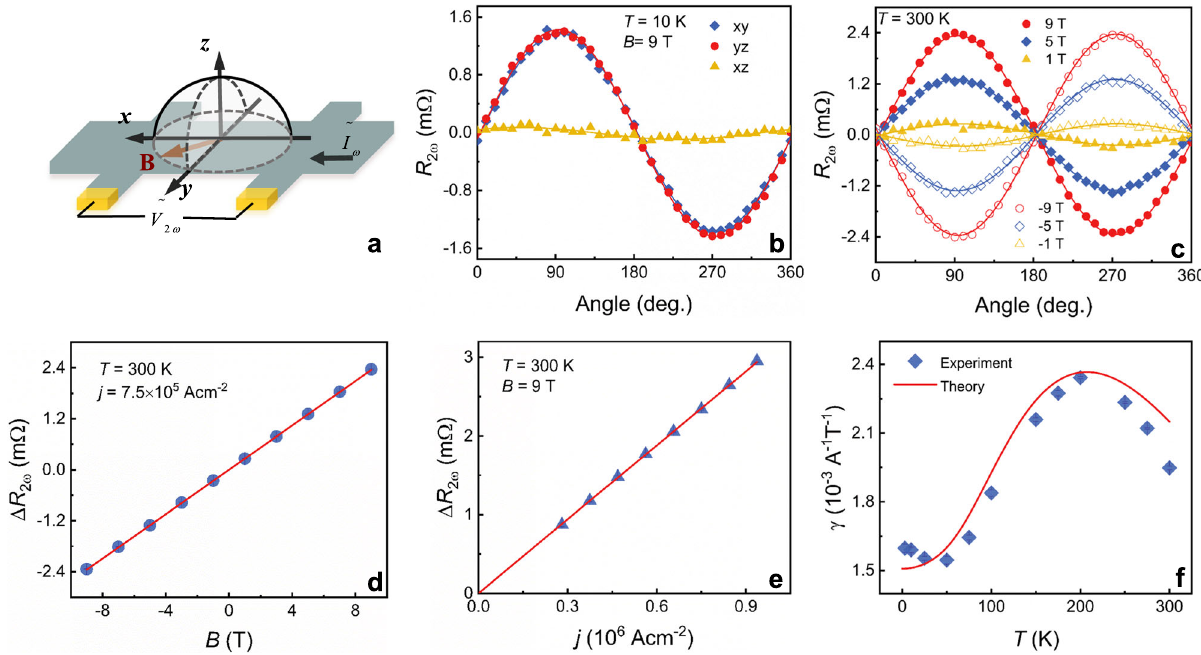
Fig. 2 Unidirectional magnetoresistance in α -GeTe fi lms. a Schematic diagram of ac harmonic measurement con fi gurations with ac current applied along x -axis. b Dependence of the second-harmonic longitudinal resistance R 2 ω on angles in three different geometries with the current density j ¼ 7 : 5 ´ 10 5 Acm (cid:1) 2 at 10 K and 9 T. c R 2 ω as a function of in-plane magnetic- fi eld angle ( xy -scan) at 300 K under various magnetic fi elds, where the symbols are experimental data and the solid curves are the fi ts to Δ R 2 ω sin φ . d Magnetic fi eld-dependent Δ R 2 ω extracted from c with j ¼ 7 : 5 ´ 10 5 Acm (cid:1) 2 . e Δ R 2 ω as a function of the applied ac current amplitude at 300 K and 9 T. f Temperature dependence of γ . The cyan symbols are the experimental results and the red line is from the theoretical